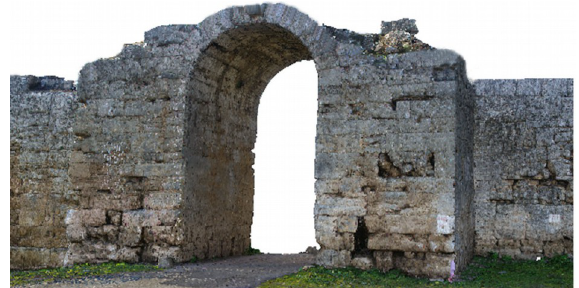
Figure 3. Point Clouds of “ Porta Sirena” in north-east view